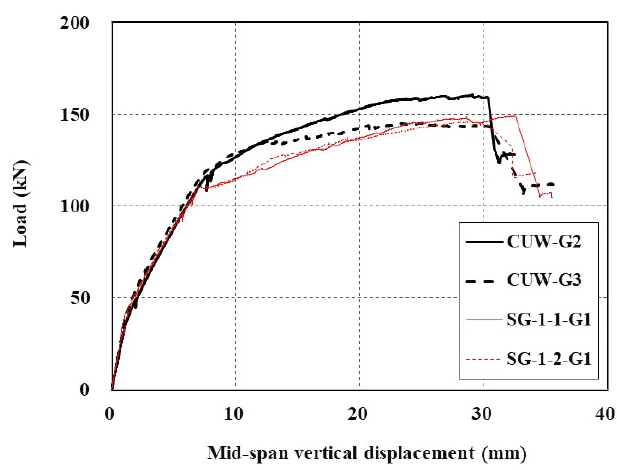
Figure 14. Load-displacement curves for CUW series and SG-1 series [28] specimens.